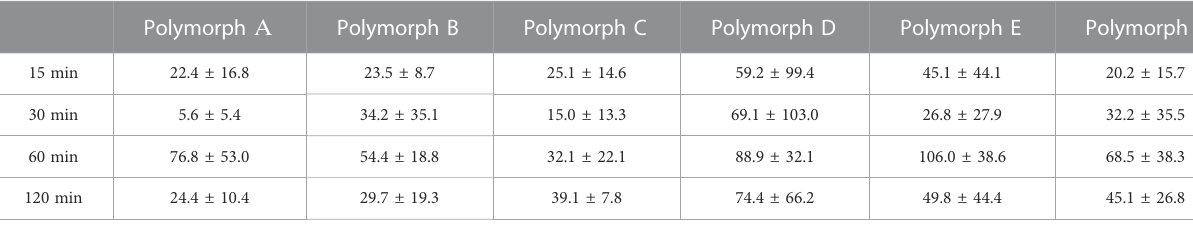
TABLE 7 Concentration of latrepirdine in brain tissues, ng/mg — individual data and mean